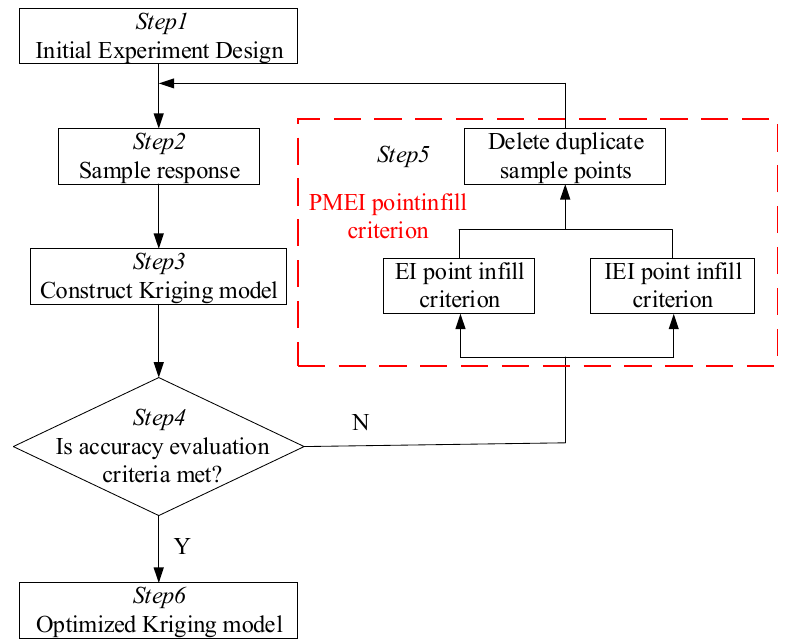
Figure 1. The flowchart of the PMEI method.